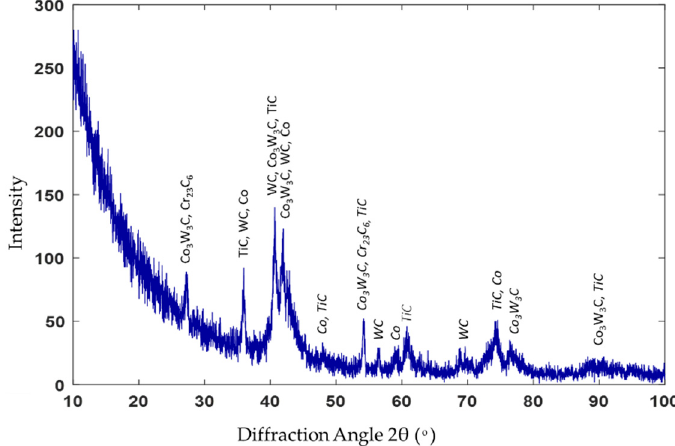
Figure 13. XRD spectrum of sample 2.